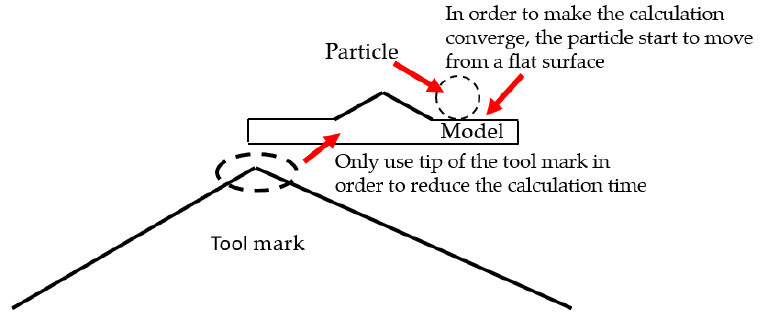
Figure 3. Schematic of the finite element model.